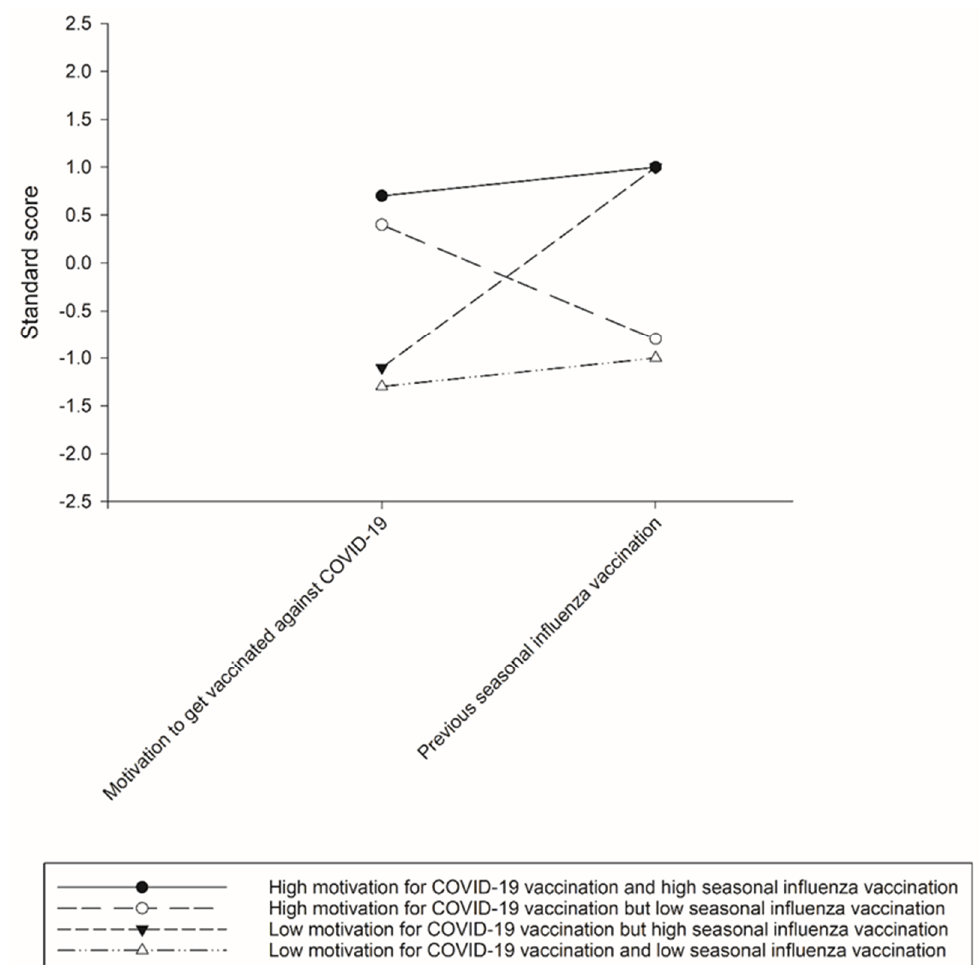
Figure 1. Four classes of participants with various levels of motivation to get COVID-19 vaccination and previous seasonal influenza vaccination.